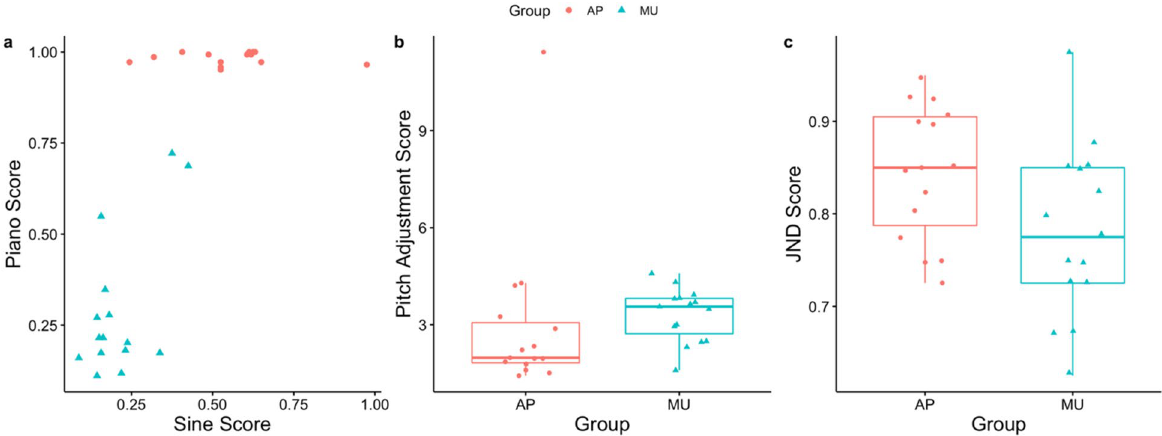
Figure 1. Spread of Behavioral Data. Individual data points are provided for individual subjects. Red circles represent individuals who self-report as an AP possessor, while turquoise triangles represent other musicians. ( a ) Comparison of performance on the AP sine tone conservative measure compared to performance on the AP piano tone conservative measure. ( b ) Performance on the pitch adjustment task. ( c ) Performance on the just- noticeable-difference